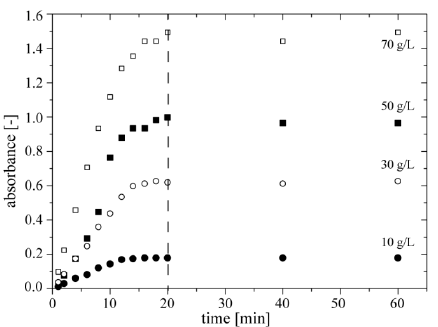
Figure 5. Dependence of absorbance of quinoneimine dye at 490 nm on time of colorimetric reaction for four concentrations of ethanol (10, 30, 50 and 70 g·L −1 ).